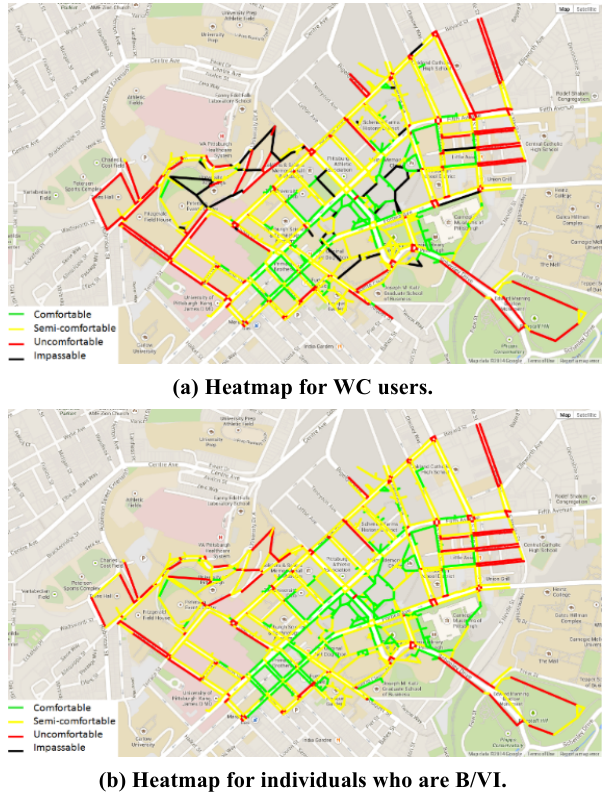
(b) Heatmap for individuals who are B/VI. Figure 8. Heatmaps for PWDs: (a) heatmap for WC users and (b) heatmap for individuals who are B/VI [23]